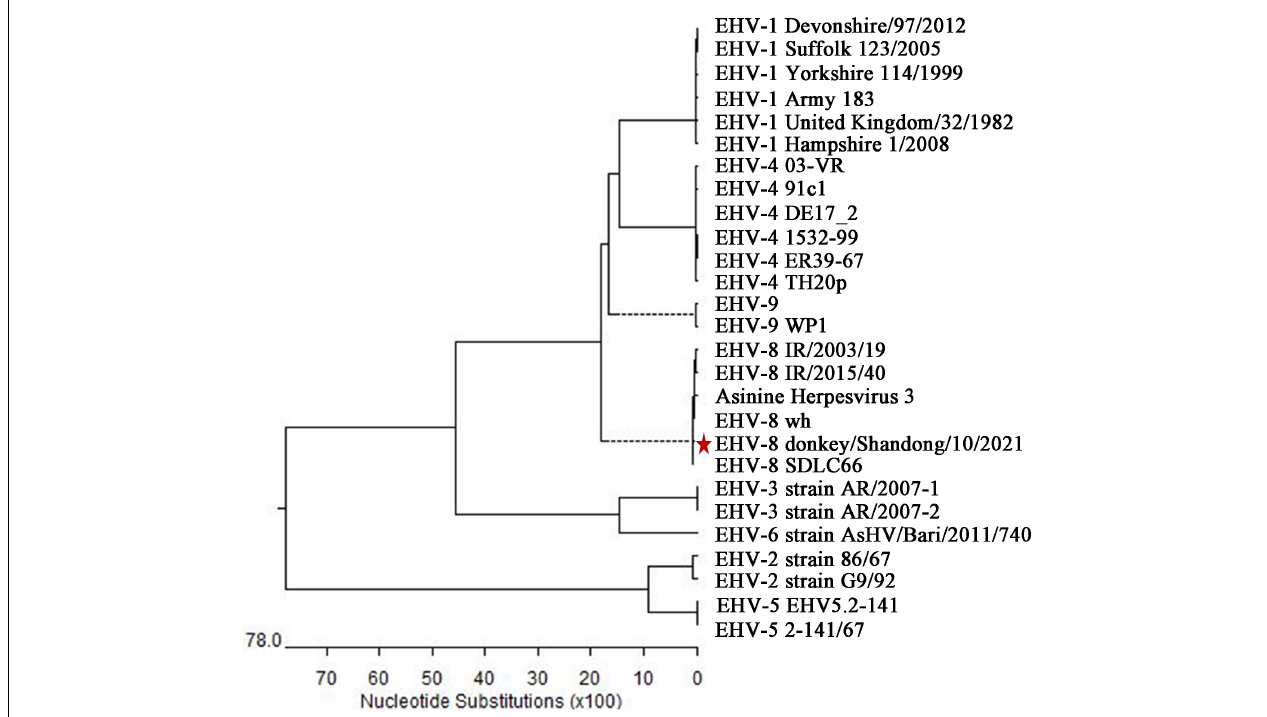
FIGURE 4 | Phylogenetic tree based on the sequence of ORF70 from the isolate in the present study and with known sequences of equine herpesviruses. Genetic variation analysis of isolates detected in the present study based on the phylogenetic trees of the ORF70 gene. The sequences of isolates of ORF70 in the present study are labeled with the scale bar indicates nucleotide substitutions per site. ∗ represent the isolate in the present study.